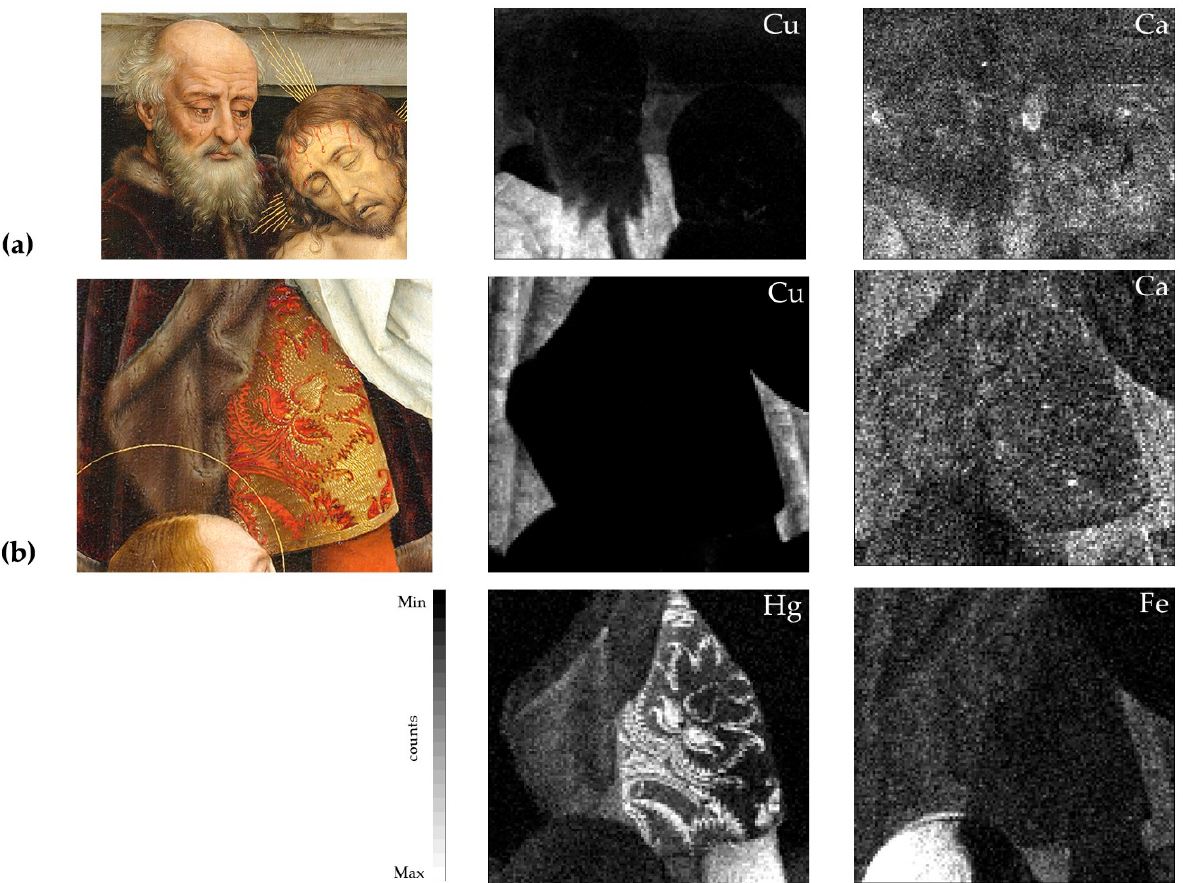
Figure 3. ( a ) Detail of the red/amaranth robe of Joseph of Arimathea, with relative Cu(K α ) and Ca(K α ) XRF maps; ( b ) detail of the red/amaranth robe of Joseph of Arimathea (lower part), with relative Cu(K α ), Fe(K α ), Hg(L α ), and Ca(K α ) XRF maps.